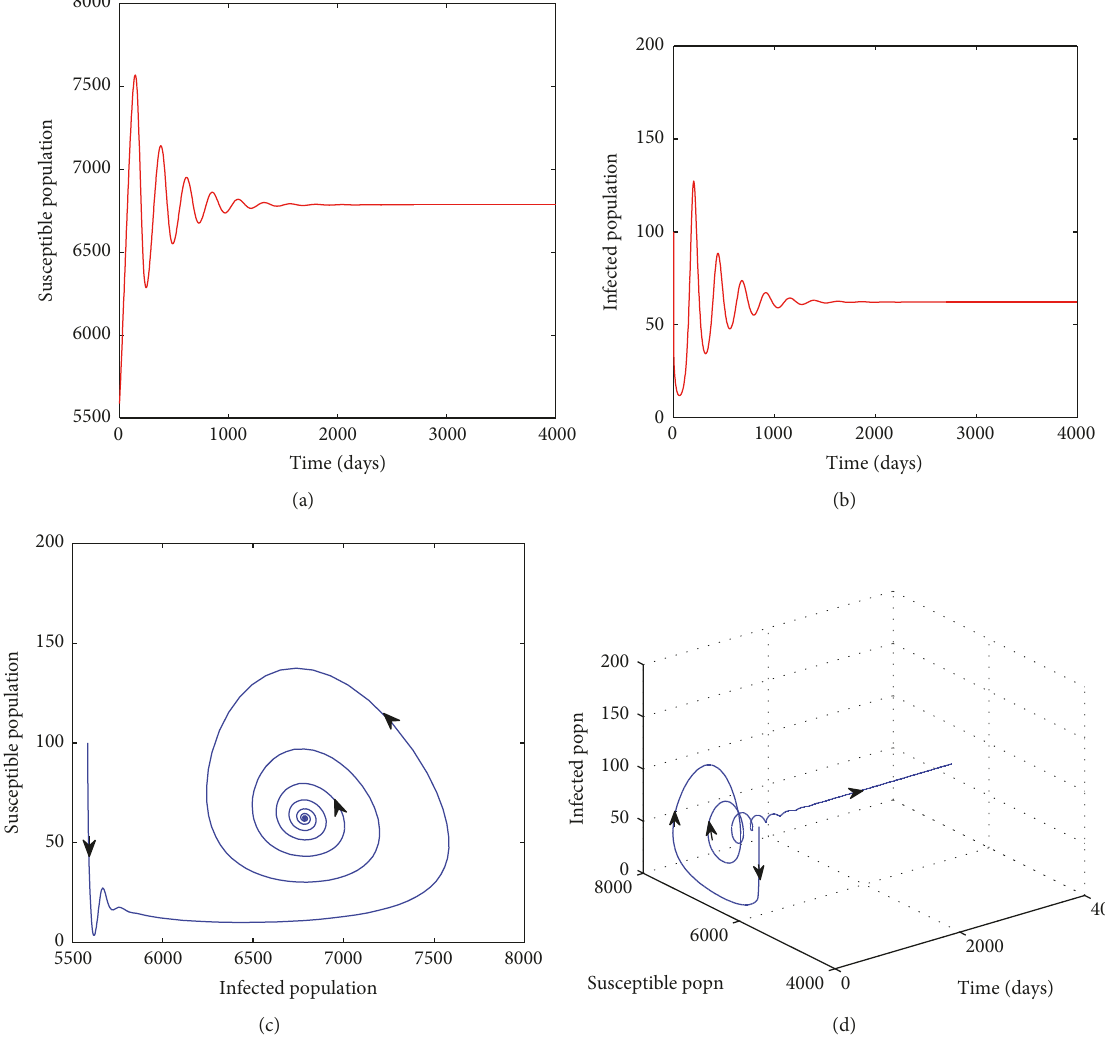
Figure 3: (a and b) Stability of the endemic equilibrium showing Hopf-bifurcation, with initial variables: 𝑆(0) = 5586 , 𝑉(0) = 22 , 𝐶(0) = 64 , 𝐼(0) = 11 , and 𝐸(0) = 100 . (c and d) The evolution of the infected, the susceptible and corresponding I-S portrait, and 3D phase trajectories, with 𝑅 0 = 15.4 , 𝑅 𝑢 0 = 15.14 , and 𝑅 V 0 = 0.271 parameters: 𝜇 = 2.0547 × 10 −4 ; 𝜙 = 3.574 × 10 −2 . The rest of the parameters remain fixed as